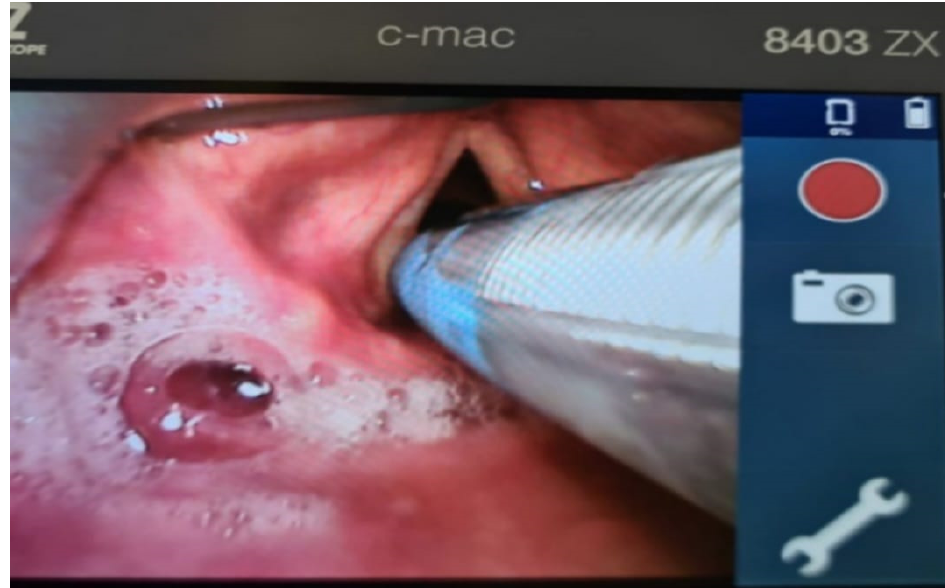
Figure 1. Videolaryngoscopic placement of the EMG-endotracheal tube using C-Mac (Stortz), without a neuromuscular blockade. The blue electrode touches the mucosa of both vocal cords to ensure a proper EMG signal during stimulation.